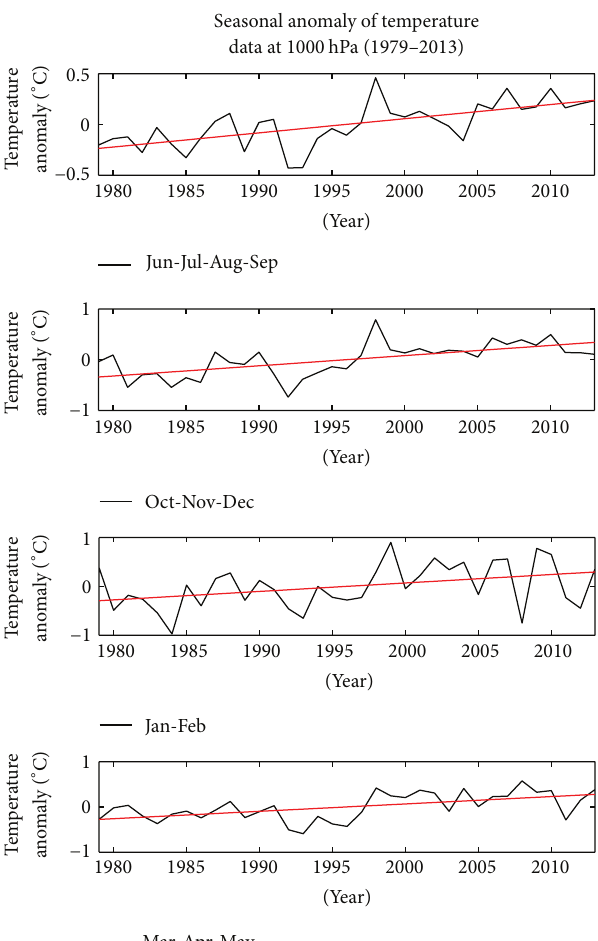
Figure 6: Seasonal anomaly of temperature at 1000